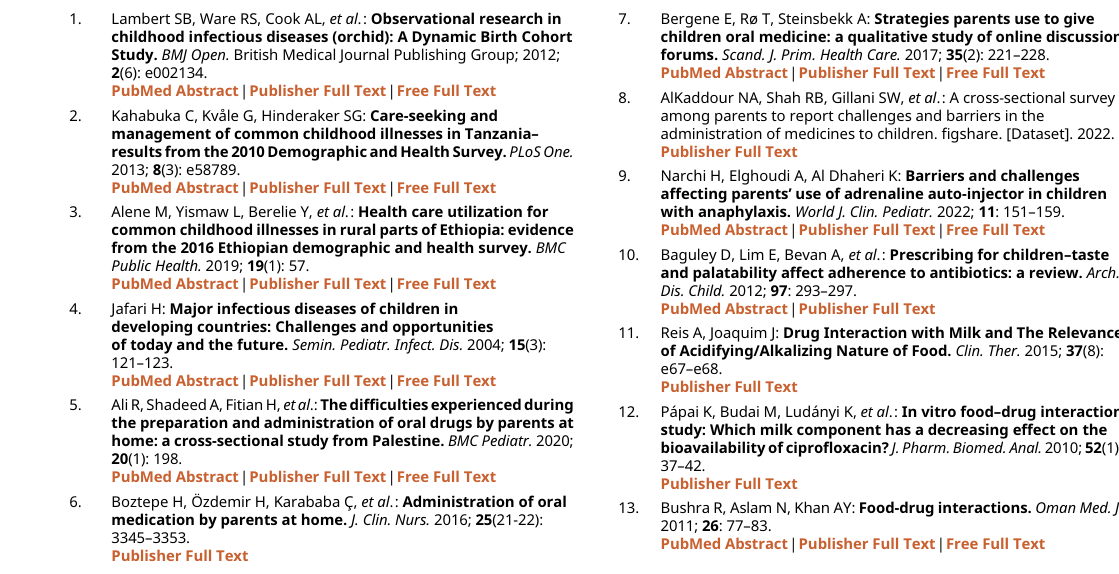
Figshare: Underlying data for ‘ A cross-sectional survey among parents to report challenges and barriers in the administration of medicines to children ’ , https://doi.org/10.6084/m9.figshare.20208938.v1. 8 (cid:129) Data file: Parents reported challenges and barriers in the administration of medicines among children.xlsx (Questionnaire responses)